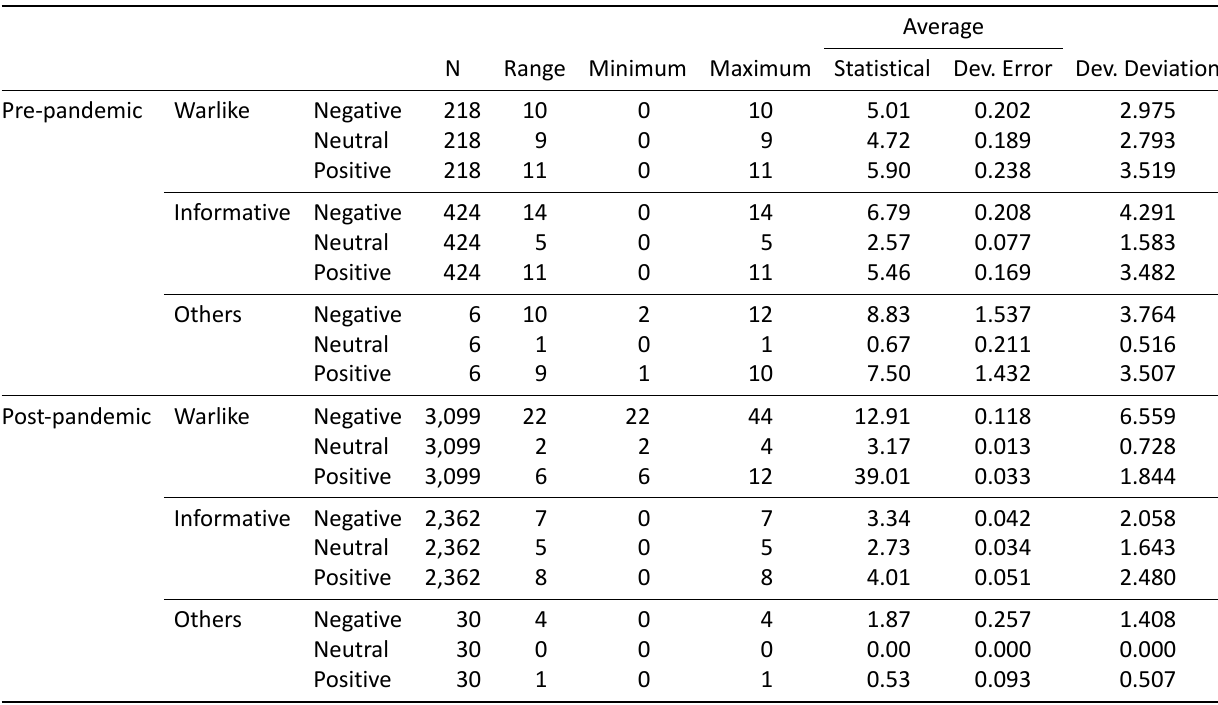
Table 3. Descriptive statistics on RQ2.